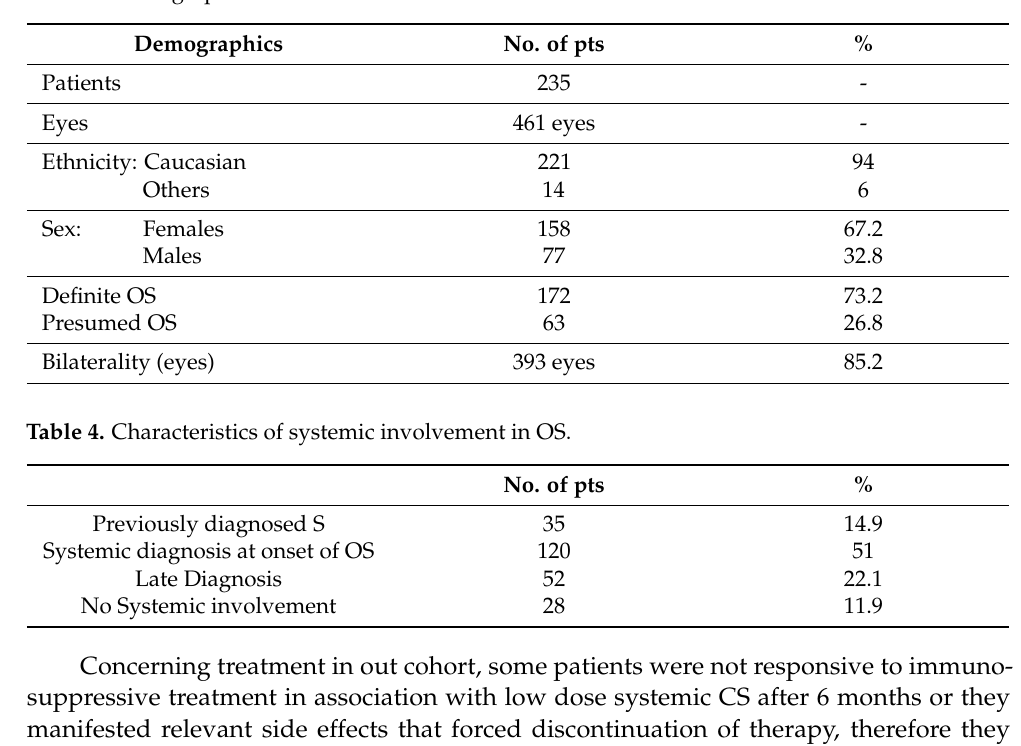
Table 3. Demographic characteristics of our cohort.